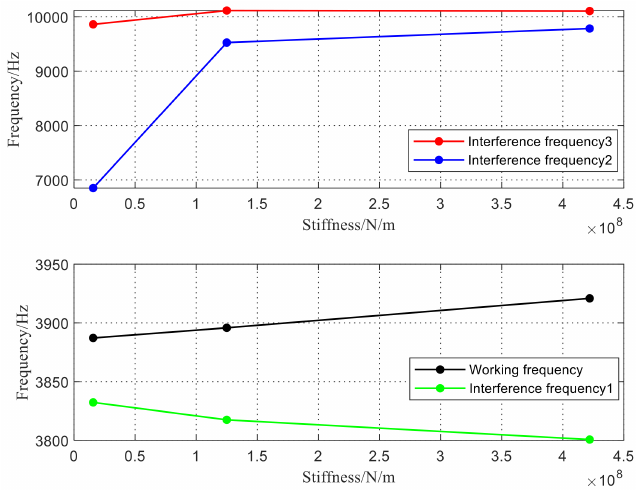
Figure 15. Stiffness frequency of three